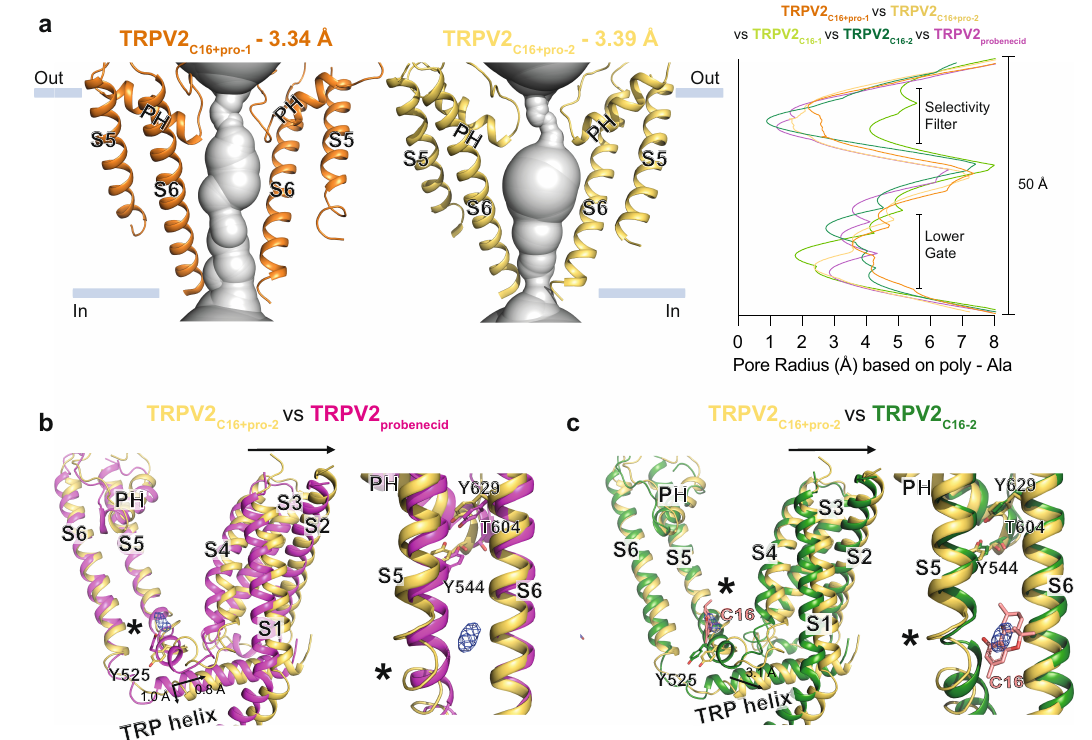
Fig.9|ThecombinedeffectofC16andprobenecidonTRPV2.a Pro fi leoftheion permeation pathway, displayed as gray space- fi lling models, for TRPV2 C16+pro-1 (orange)andTRPV2 C16+pro-2 (yellow).Thecorrespondingcalculatedporeradiusasa function of the distance along the ion conduction pathway is also shown for TRPV2 C16-pro-1 (orange),TRPV2 C16-pro-2 ,(yellow),TRPV2 C16-1 ,(lightgreen),TRPV2 C16-2 (dark green) and TRPV2 probenecid (magenta). b , c Overlay of TRPV2 C16+pro-2 with